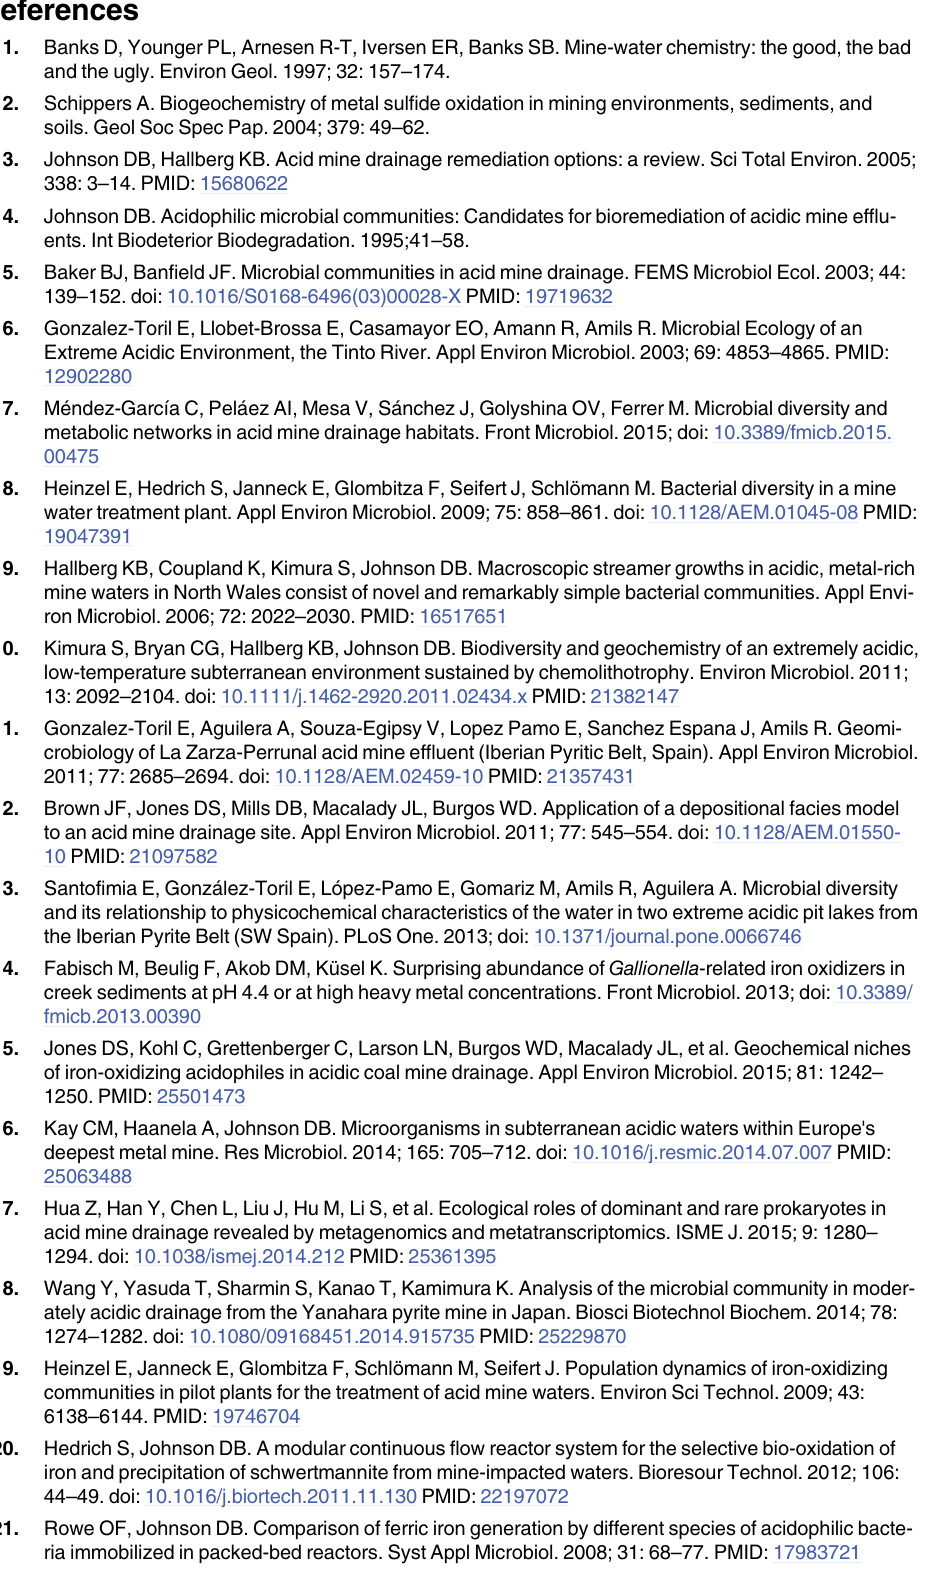
PLOS ONE | DOI:10.1371/journal.pone.0146832 January 25,